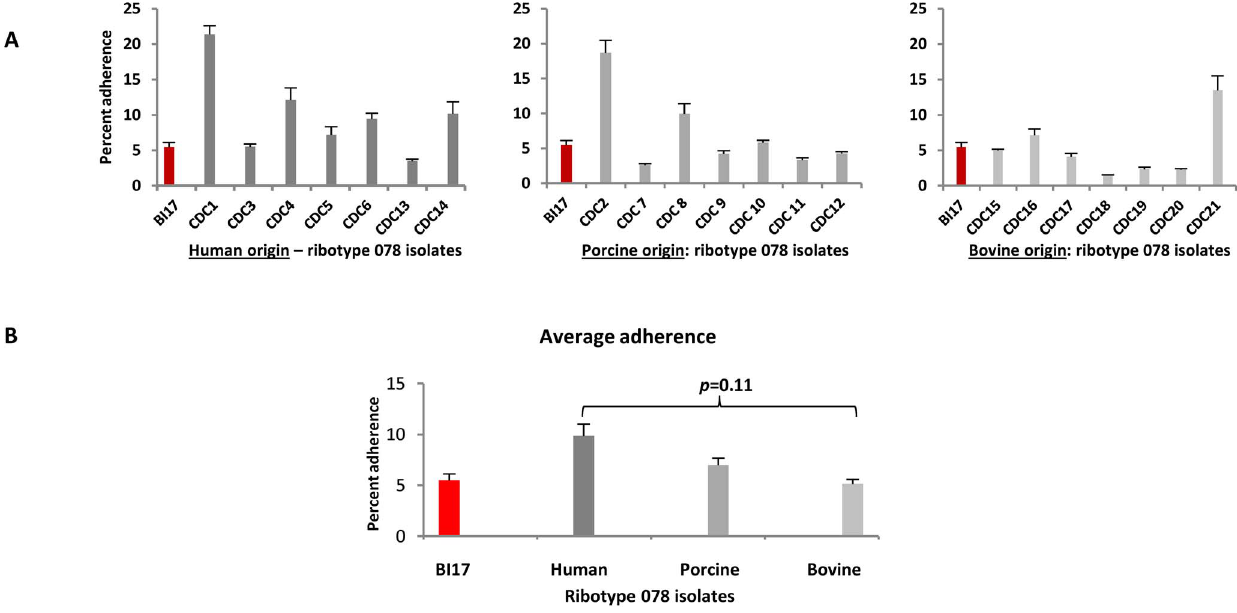
Figure 2. Adherence of ribotype 078 strains derived from different mammalian sources with symptomatic CDI. Panel A. Twenty-one ribotype 078 strains were tested for adherence to human-derived enterocytes, using the protocol described in the Methods section. Isolates were divided into those of human origin (dark gray bars; 7 total); porcine origin (medium gray bars; 7 total) and bovine origin (light gray bars; 7 total). All isolates were tested in quadruplicate, and assays were repeated in entirety at least once. The epidemic-associated BI-17 strain (red bar) was used as an internal control. Panel B. Average adherence of each group of 078 strains in comparison with a human EA strain, BI17.